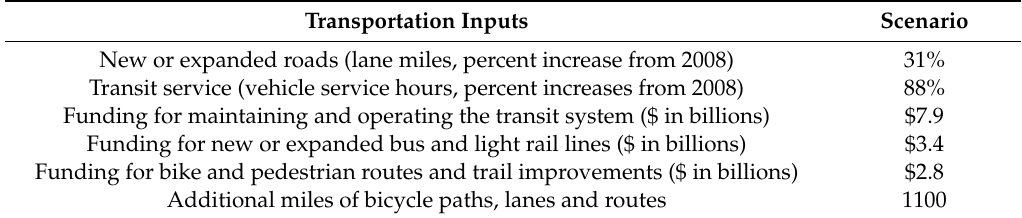
Table 1. Description of the 2016 Metropolitan Transportation Plan / Sustainable Communities Strategy (MTP / SCS) Scenario from Reference